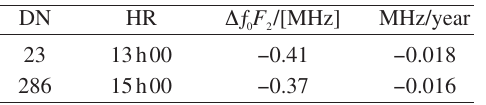
F versus DN and HR for F2, A16 = a) LL; b) HL; c) LH, and d) HH. 0 2 Table I. Peak values of negative change.